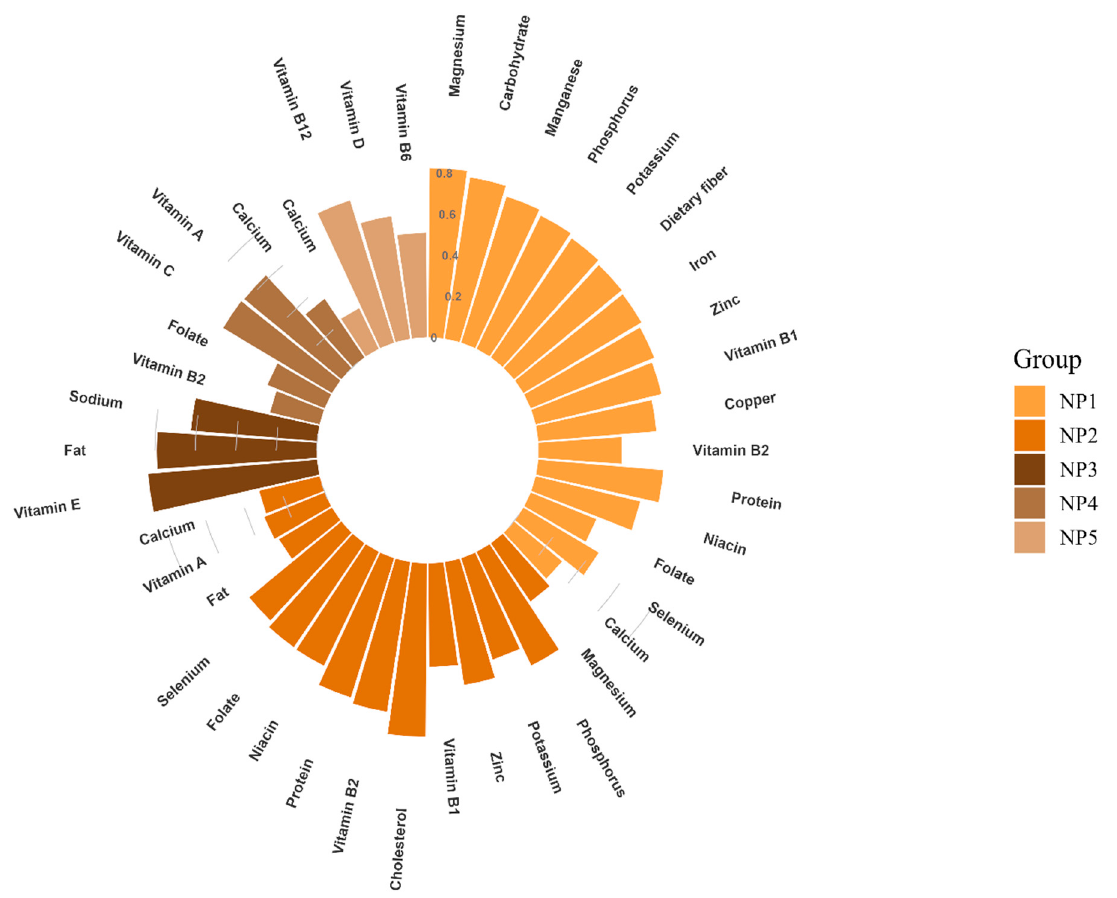
Figure 1. Factor loadings (all >0.300) of 5 Nutrient Patterns